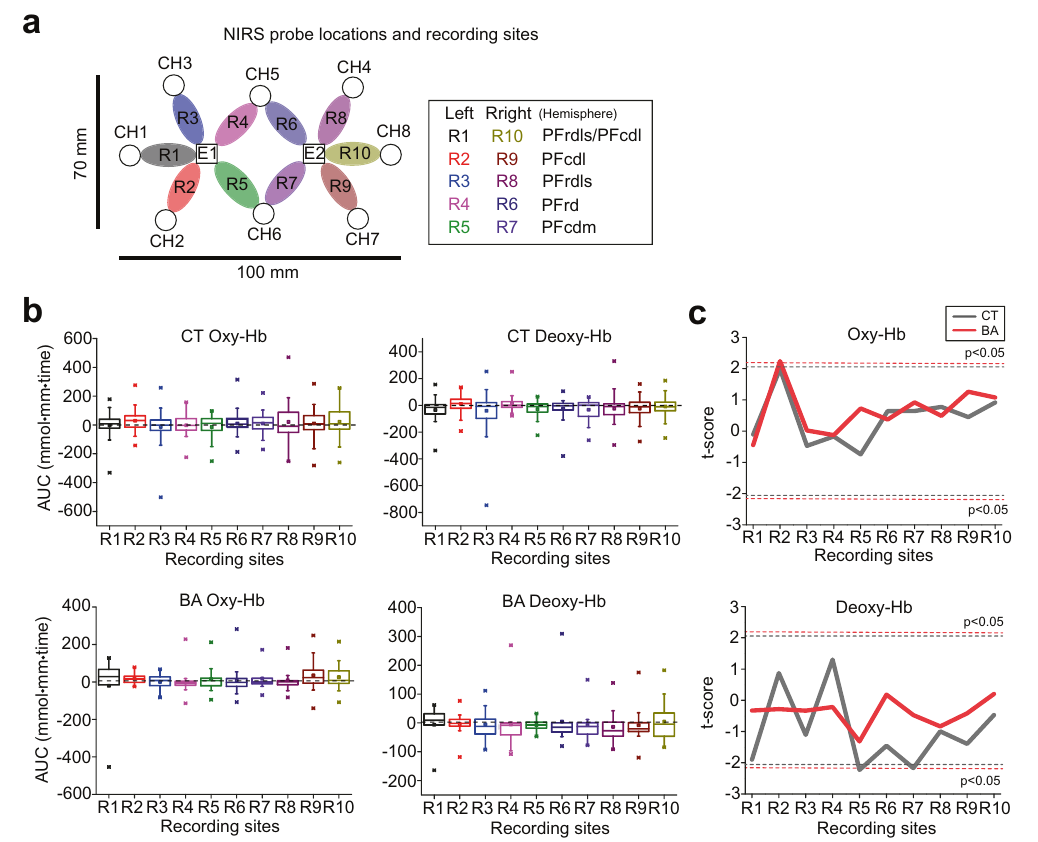
Fig. 2 Oxy-Hb and deoxy-Hb changes in the PFC associated with the PASP test. a A schematic diagram illustrating the probe (emitters = E1 – 2, detectors = CH1 – CH8) locations and the recording sites (R1 – R10) on the skull. b Graphs showing oxy-Hb and deoxy-Hb changes during the PSAP test at each recording site in behavioural addiction (BA) patients and control (CT) subjects. c Graphs showing t -scores of oxy-Hb (top) and deoxy-Hb (bottom) changes at each recording site. Dashed lines indicate the thresholds above or below which t -scores are statistically signi fi 0.011; Fig. 1a), whereas the number of choices to attack the imaginary opponent and the number of choices to protect point subtractions did not differ between BA patients and CT subjects (Mann – Whitney U test Z = 1.01, p = 0.314; Fig. 1a). There was no